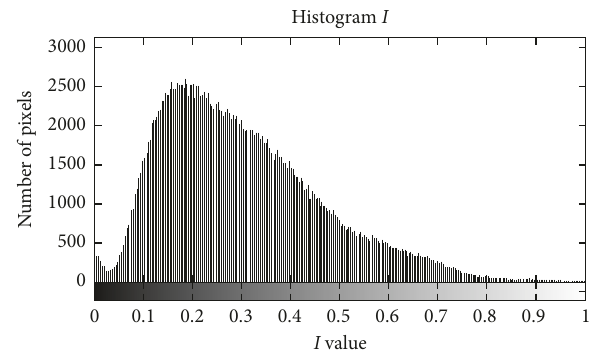
Figure 3: Variation of the intensity component ( I ) with the j- coordinates at i 150 (section AA in Figure 2). (cid:29)